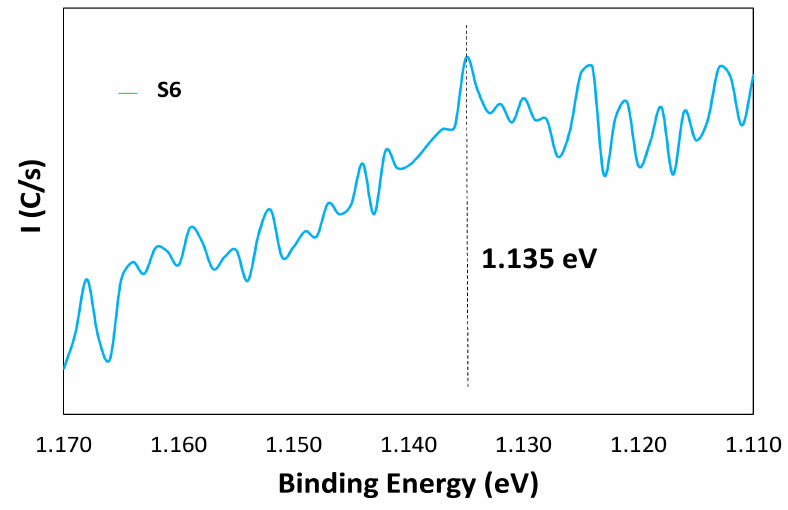
Figure 5. Ag M5NN Auger spectrum obtained from the sample